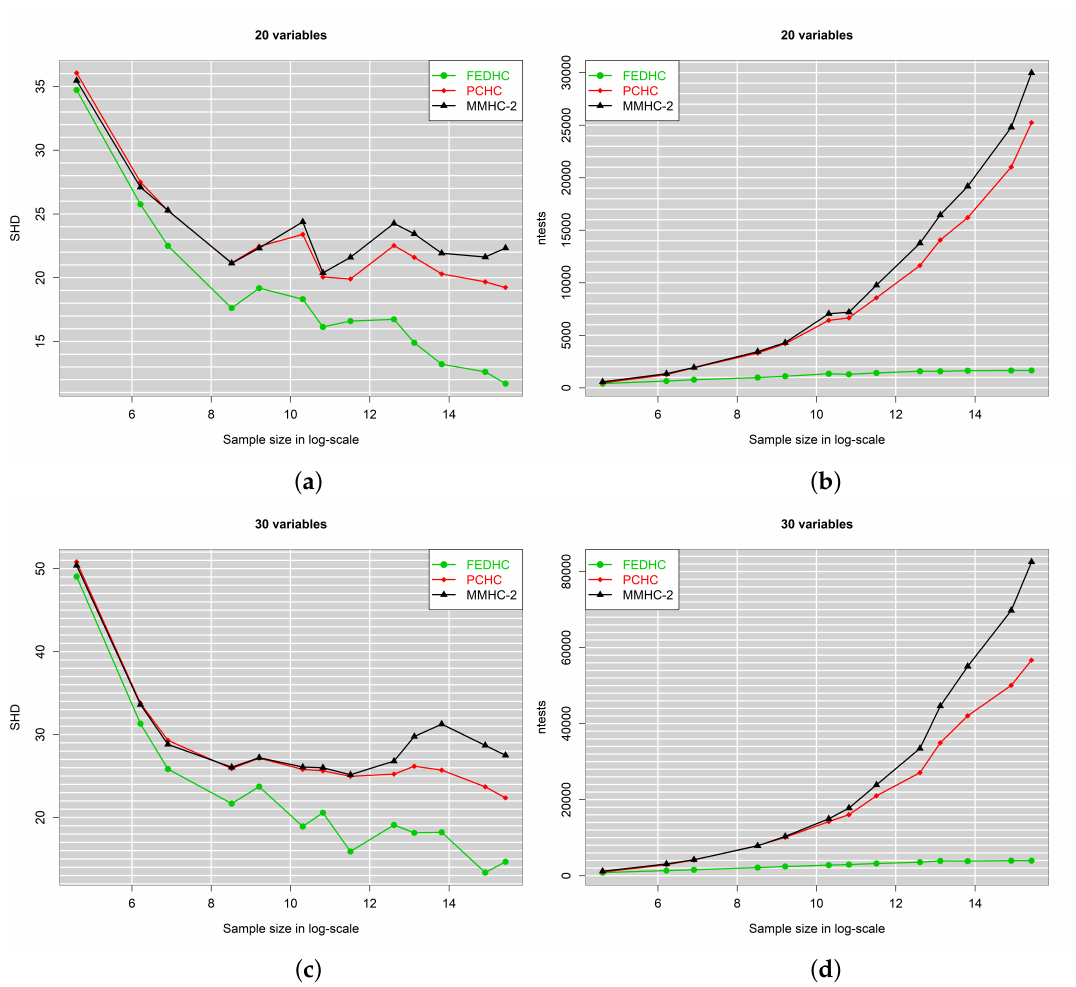
Figure 4. SHD and number of CI tests against log of sample size for 20 and 30 dimensions, with 5neighbours on average. ( a ) SHD vs. log of sample size. ( b ) Number of CI tests vs. log of sample size. ( c ) SHD vs. log of sample size. ( d ) Number of CI tests vs. log of sample